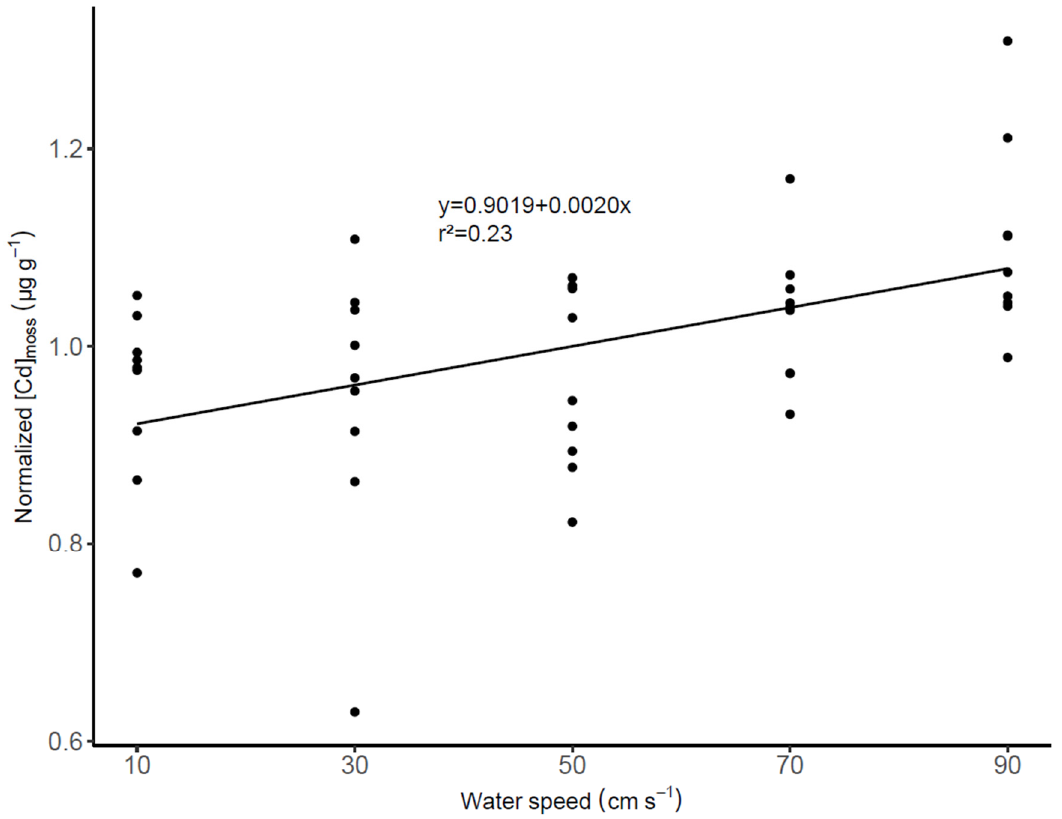
Figure 3. Linear regression of the concentration of Cd in Fontinalis antipyretica transplants normalized by the Cd concentra- tion in water, depending on water velocity. The formula and the adjusted r 2 of the model are shown. The intercept and the slope are significant ( p < 0.05).